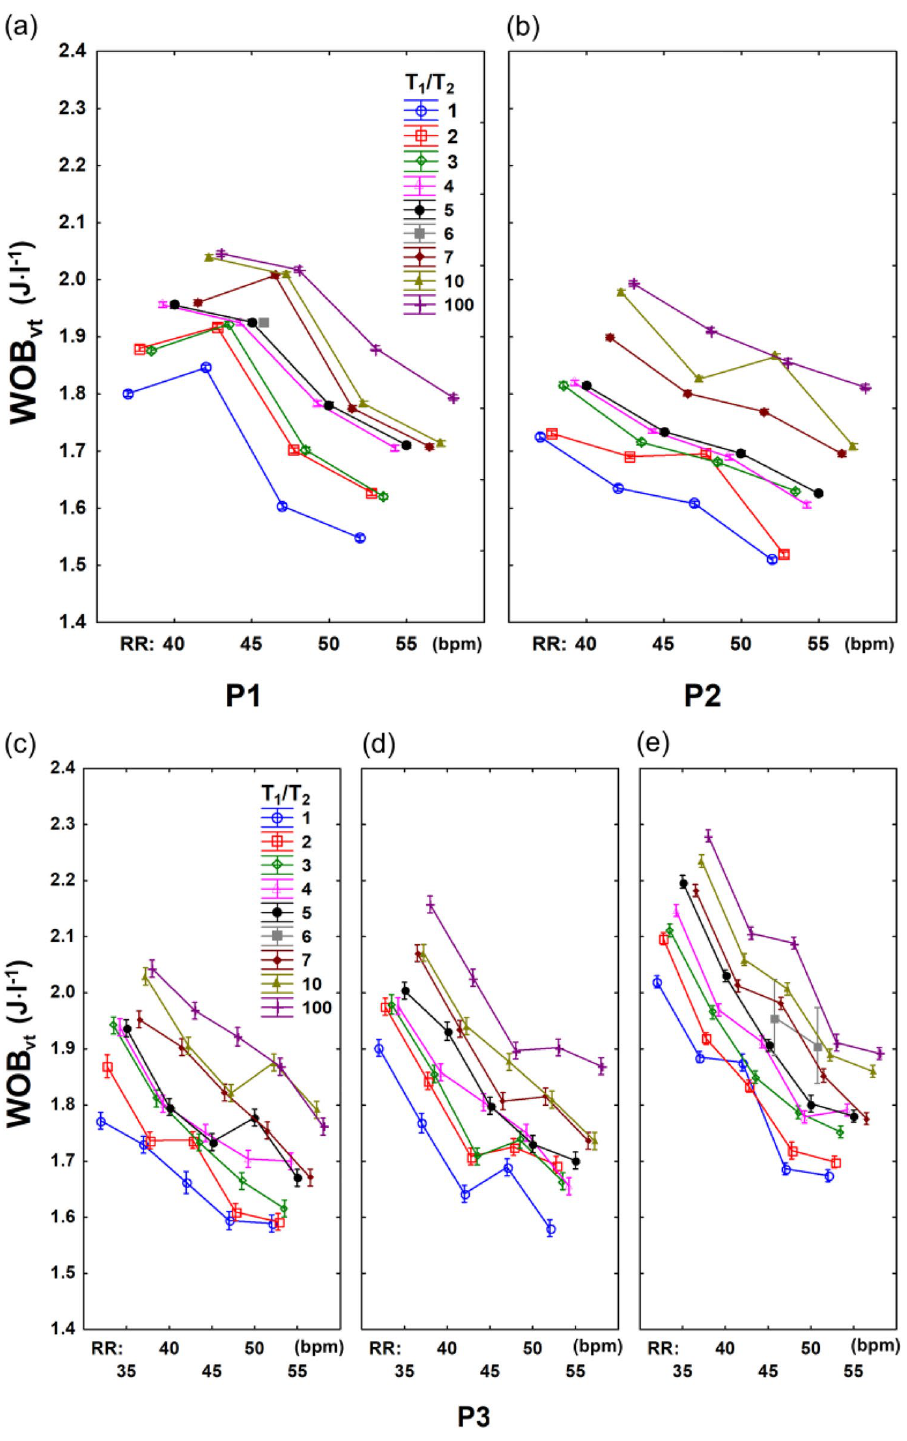
Figure 5. Relationship between work of breathing (WOB vt ) and respiratory rate (RR) depending on the T 1 / T 2 index and the C w /C L ratio in patient P 1 (R = 244 cmH 2 O·s/l, C = 0.8 ml/cmH 2 O, C w /C L = 15) ( a ), P 2 (R = 188 cmH 2 O·s/l, C = 1.26 ml/cmH 2 O, C w /C L = 12) ( b ) and P 3 (R = 205 cmH 2 O·s/l, C = 1.14 ml/cmH 2 O) with C w /C L = 5 ( c ), C w /C L = 8 ( d ), and C w /C L = 12 ( e